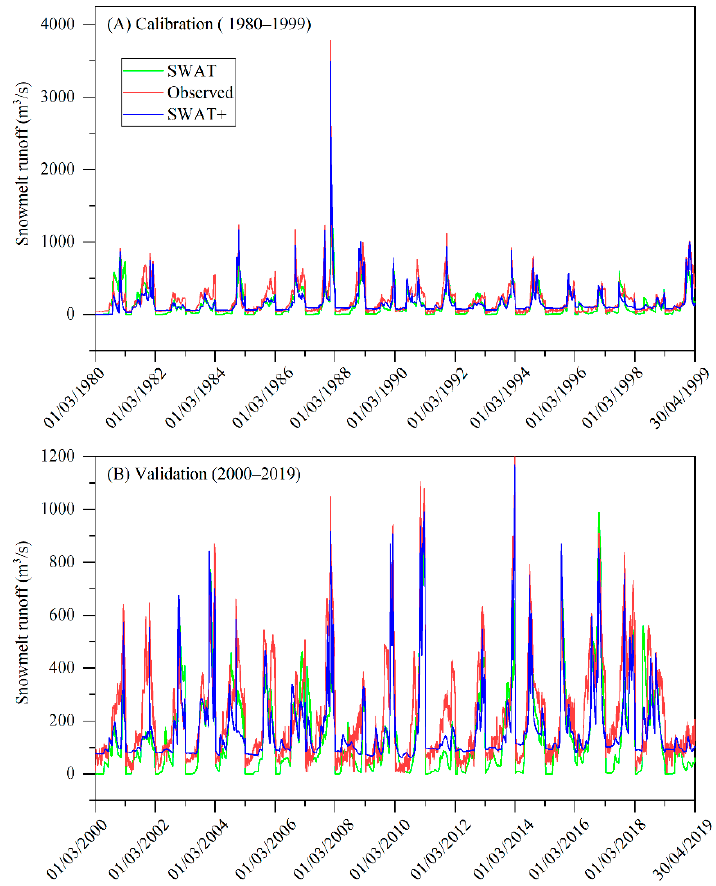
Figure 7. Snowmelt runoff simulations from March to April during calibration period ( A ) and validation period ( B ) of SWAT model and SWAT+ model. Table 2. Snowmelt runoff simulation accuracy of SWAT model and SWAT+